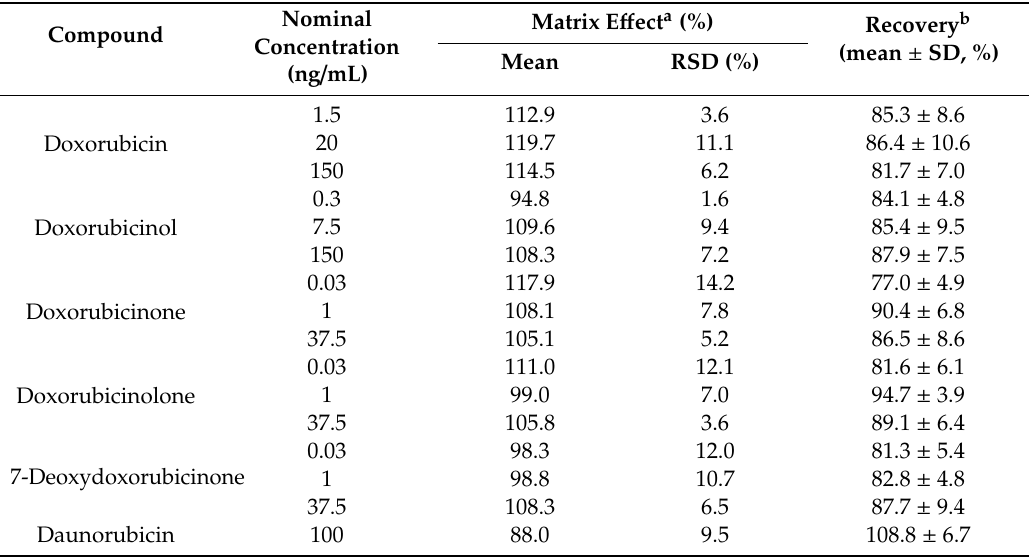
Table 2. Matrix e ff ects and recoveries of doxorubicin, doxorubicinol, doxorubicinone, doxorubicinolone, 7-deoxydoxorubicinone, and daunorubicin (internal standard) using six di ff erent mouse plasma samples ( n = 6). Nominal Matrix E ff ect a (%) Recovery b Compound Concentration RSD (%) (ng / mL) Doxorubicin